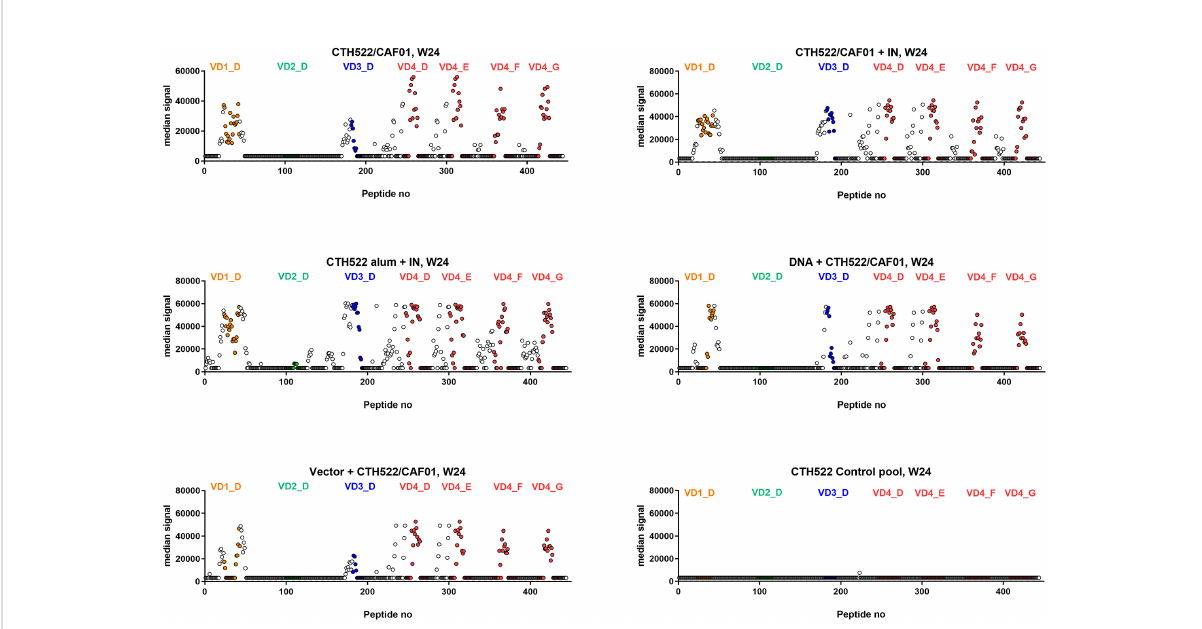
FIGURE 3 Serum epitope mapping at week 24. Cynomolgus macaques were immunized following different prime-boost regimes (n = 5 per group) and serum was collected at week 24. Peptide array IgG responses to CTH522 15mer overlapping peptides are presented as the median signal for each group with VD1 peptides (orange), VD2 (green), VD3 (blue) and VD4 from SvD, E, F and G (red) highlighted in